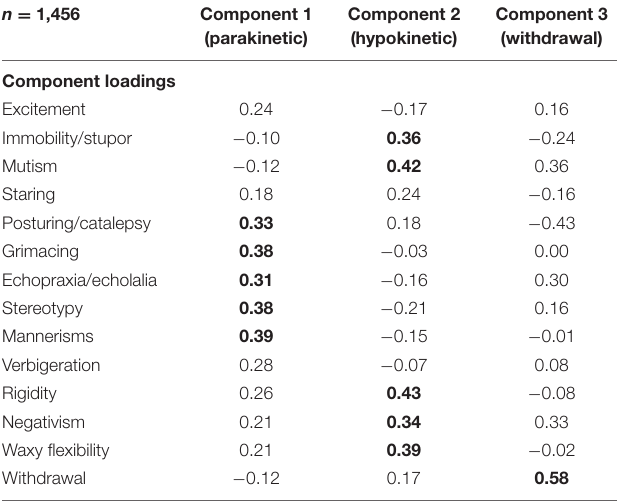
0.17 0.58 Coefficients with magnitude > 0.3 are shaded and shown in bold. Where a clinical feature had a loading of > 0.3 on more than one component, the coefficient for the component with the highest loading has been